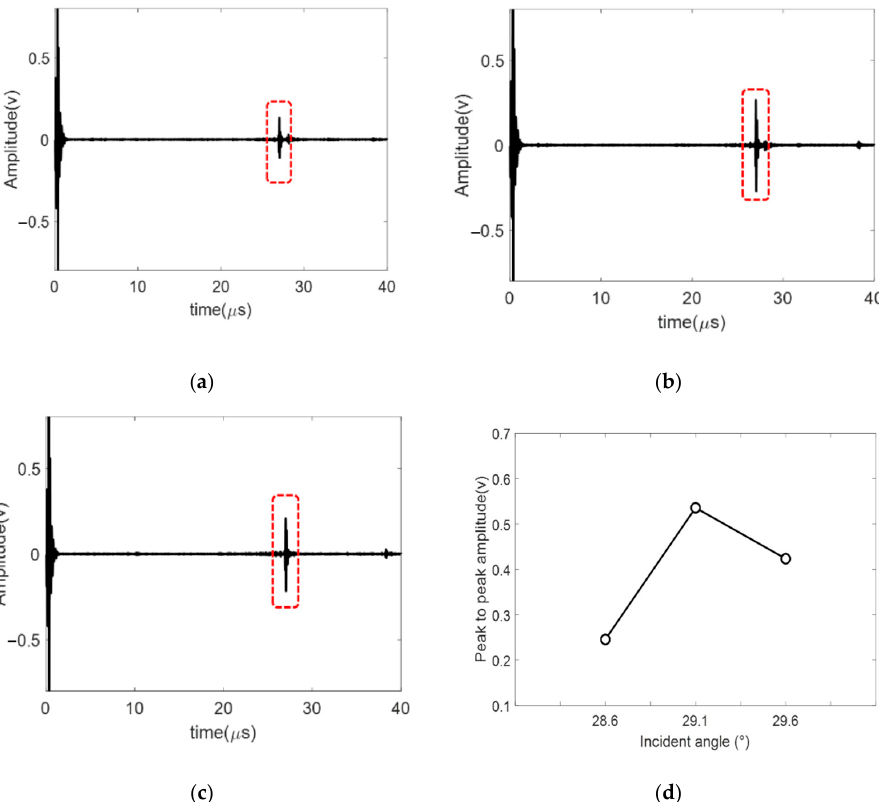
Figure 9. A-scan images of incident angles for Rayleigh waves: ( a ) 28.6°, ( b ) 29.1°, ( c ) 29.6°, and ( d ) peak-to-peak. ( d )